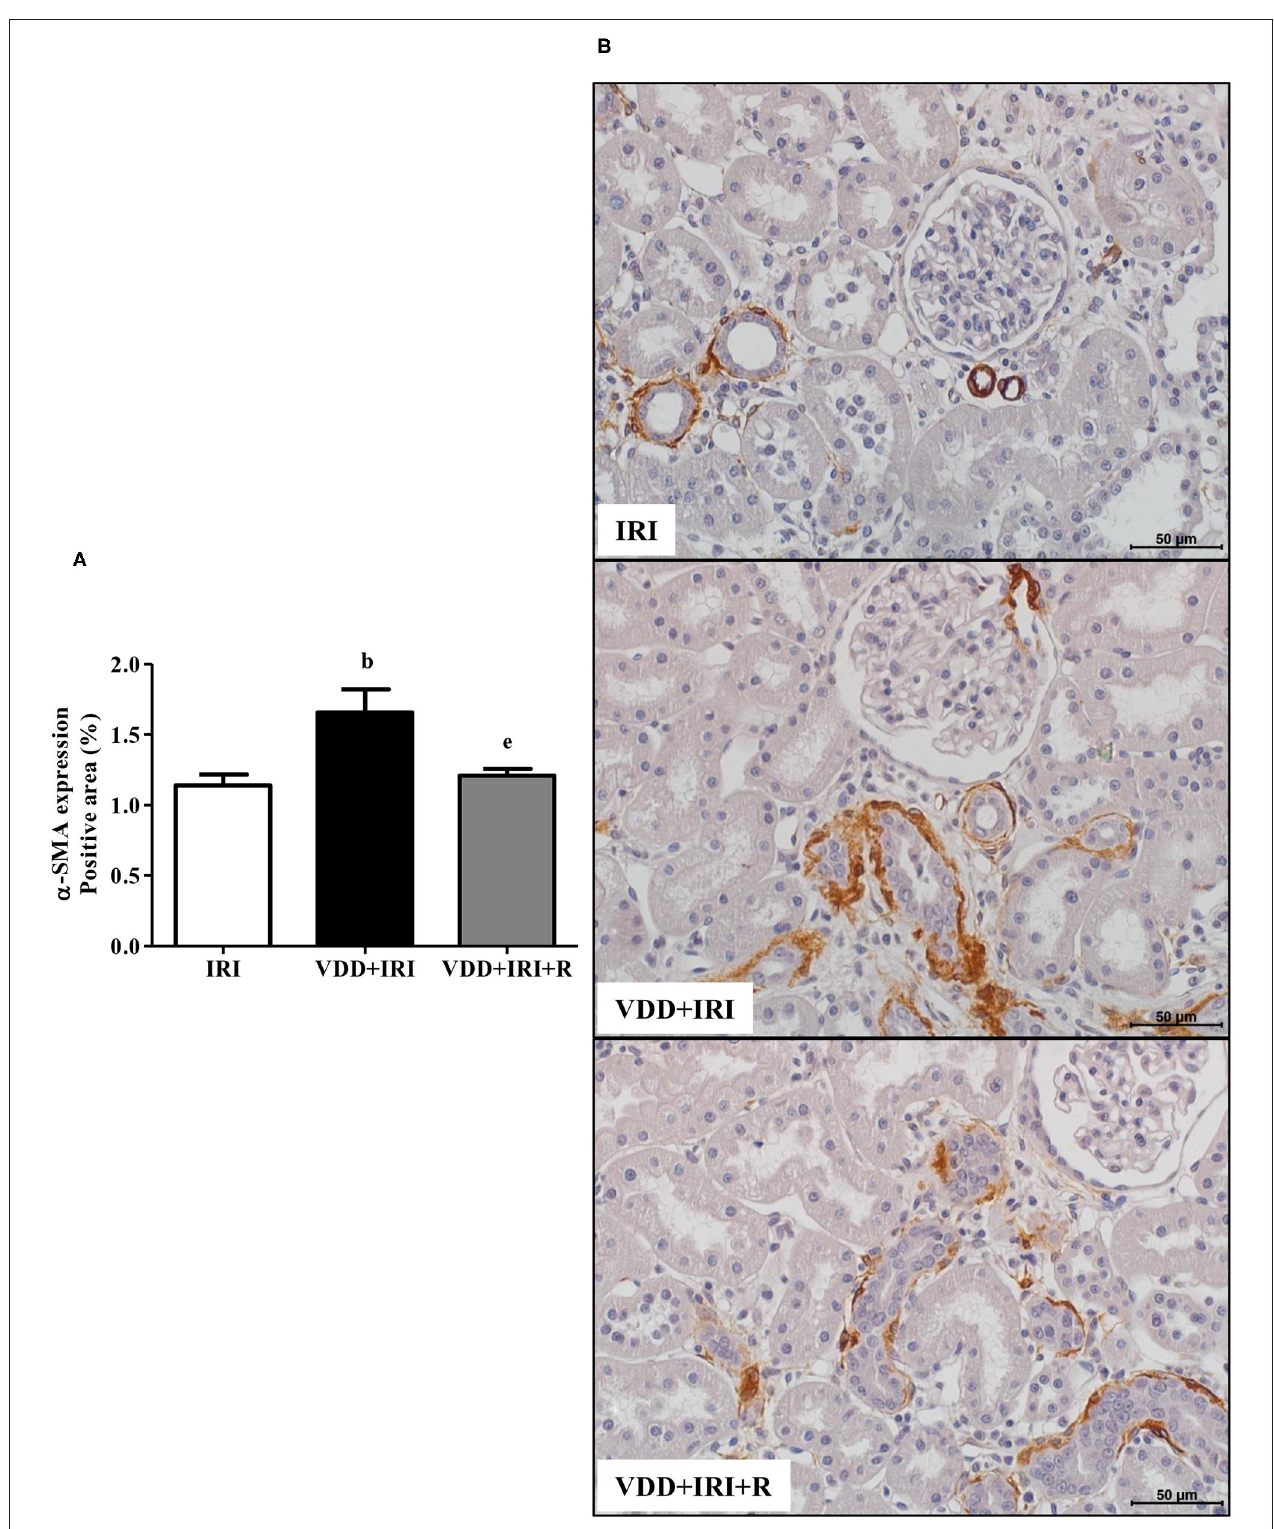
FIGURE 9 | Immunohistochemical analysis for α -smooth muscle actin ( α -SMA) expression in the kidney tissue evaluated 90 days after ischemia/reperfusion insult (IRI) on day 30. (A) Bar graph of α -SMA expression values. (B) Representative photomicrographs of immunostaining for α -SMA in the renal cortex from an IRI, VDD + IRI and VDD + IRI + R rat ( × 400). Note that vitamin D replacement restored the expression of α -SMA in the VDD + IRI + R rats. Data are mean ± SEM. b p < 0.01, vs. IRI; e p < 0.01 vs. VDD + IRI. VDD, vitamin D deficiency; R, vitamin D replacement. Diet protocol: IRI, standard diet for 120 days; VDD + IRI, vitamin D-free diet for 120 days; and VDD + IRI + R, vitamin D-free diet in the first 30 days and standard diet in the last 90 days.